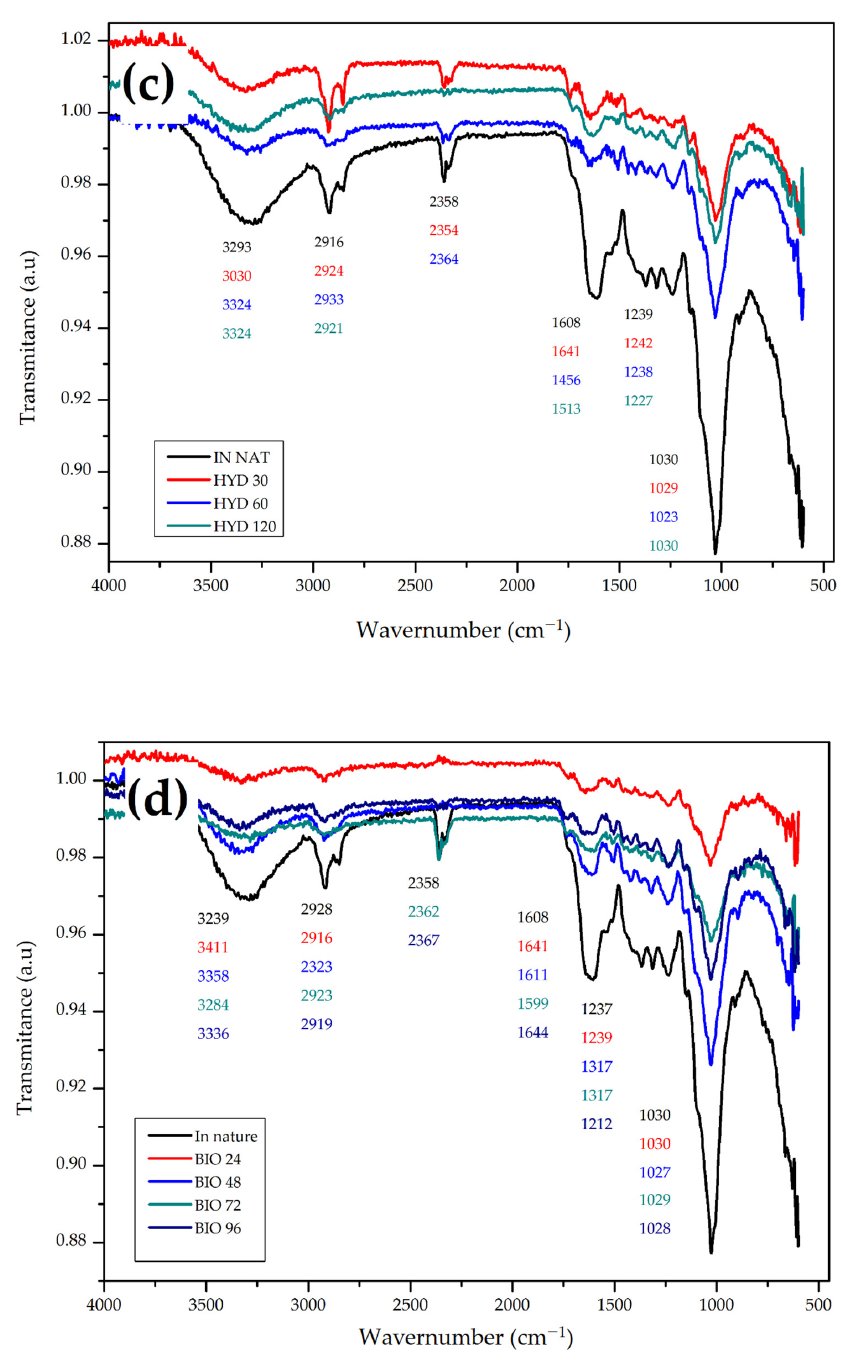
Figure 3. FTIR spectrum of ( a ) in natura CHFW; ( b ) NaOH; ( c ) HYDRO; and ( d ) BIO treatments.